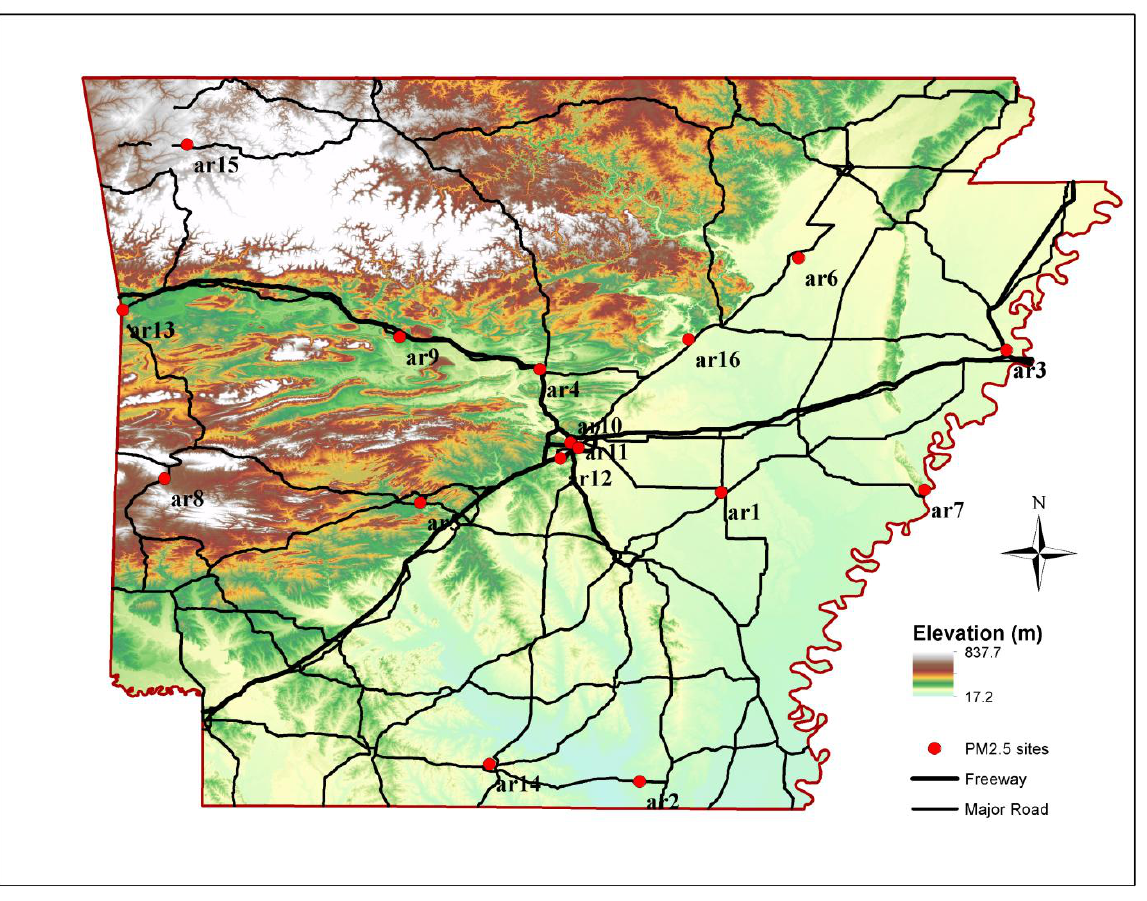
monitoring sites in 2.5